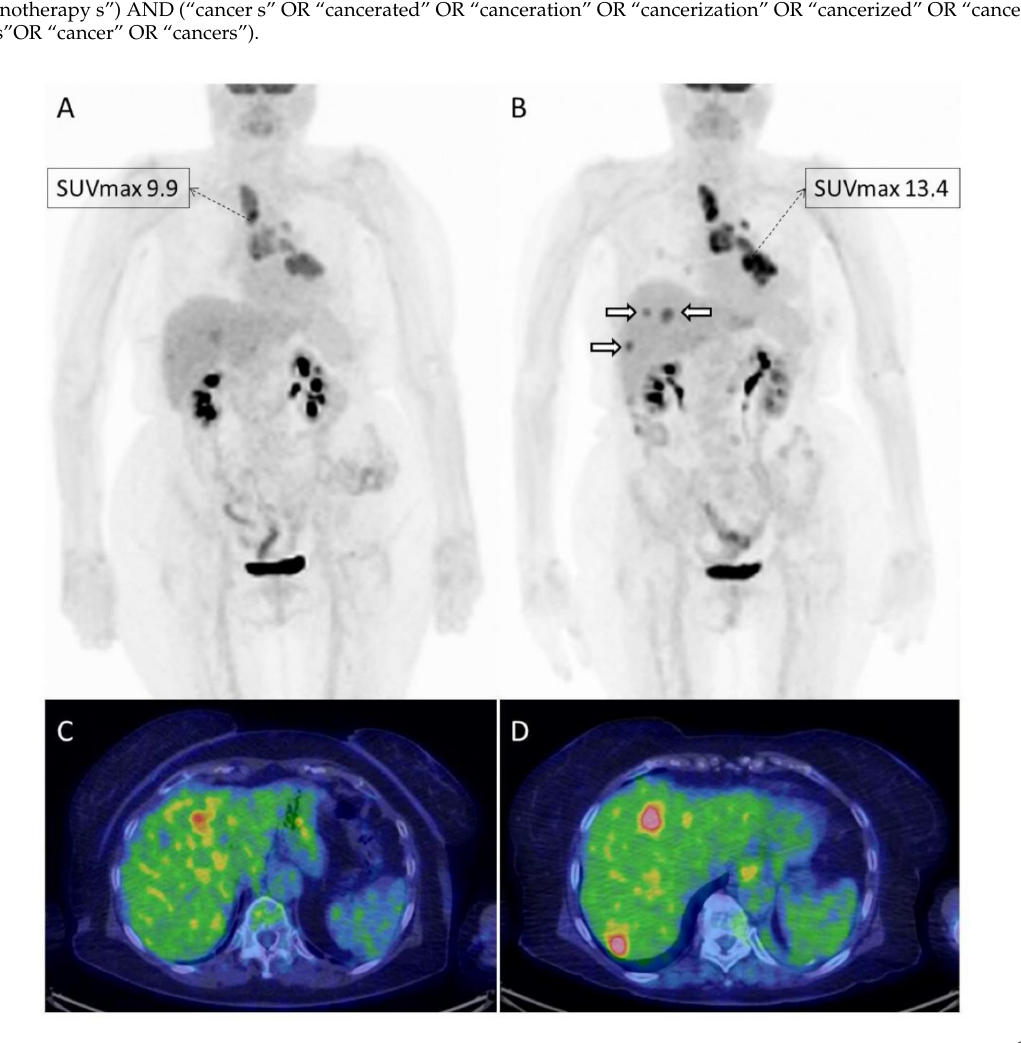
Figure 2. Example of a 78-year old female with advanced NSCLC treated with nivolumab and imaged with [ 18 F]FDG PET/CT at baseline ( A , C ) and after 4 cycles of therapy ( B , D ). The patient resulted in overall stable on morphological imaging performed prior to PET/CT, which on the contrary documented a progressive metabolic disease. In fact, the tumor had an increase in metabolism (SUVmax and MTV), and showed the appearance of new lesions in the liver (( B ); white hollowed arrows), only partially detectable on baseline